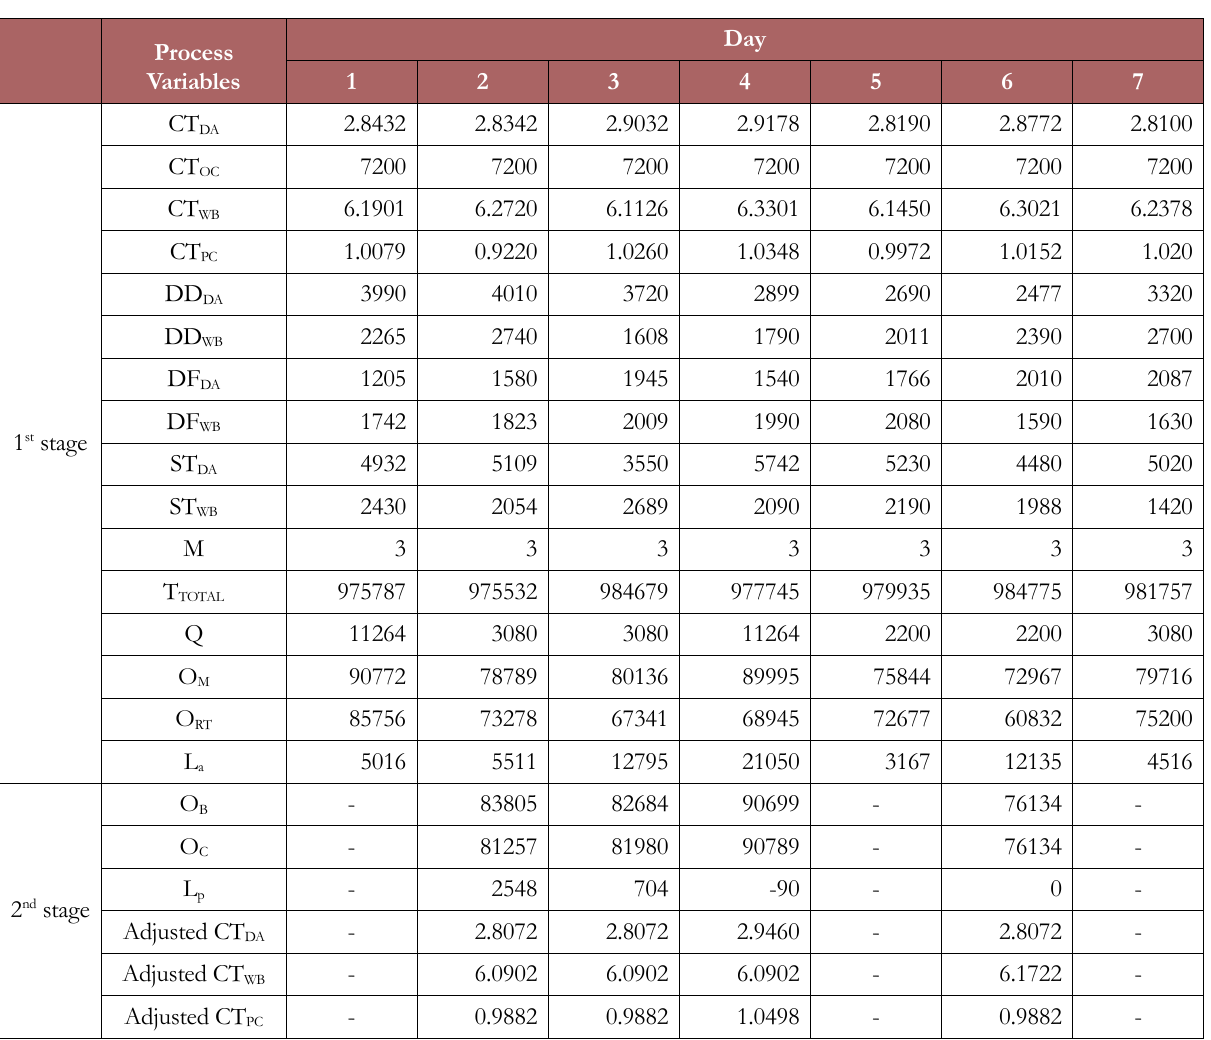
Table 3. 1 st Stage and 2 nd Stage of Production Planning for 2 nd